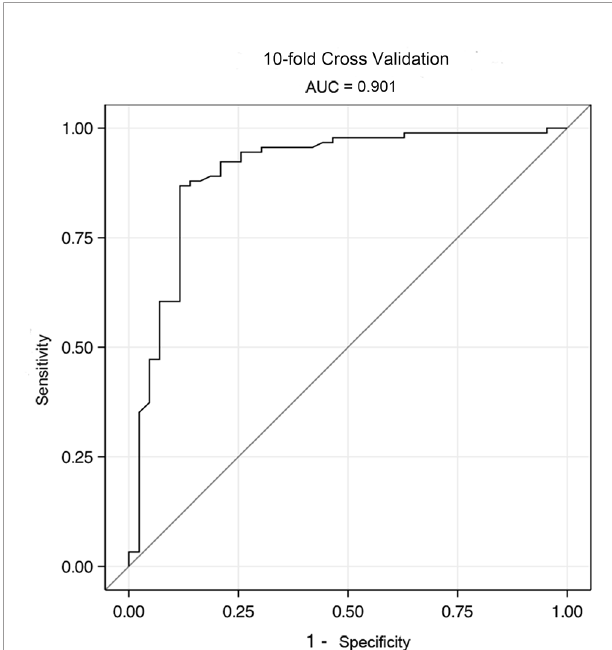
FIGURE 5 | The ROC of validation model by 10-fold cross validation. The AUC for 10-fold validation was